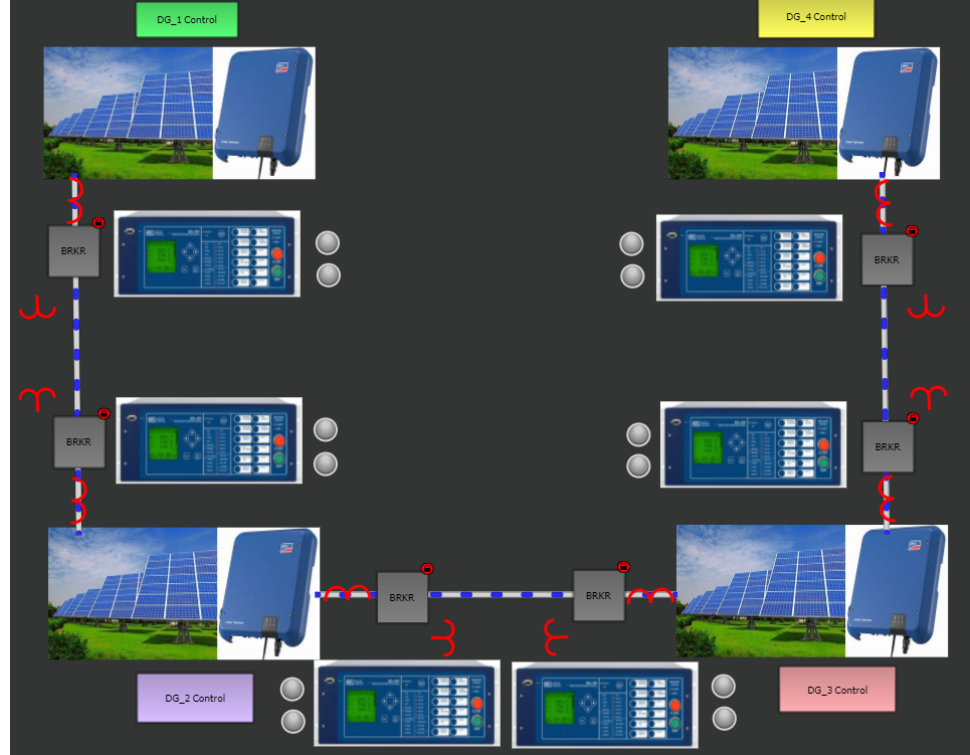
Figure 14. Human–machine interface (HMI) for the user.